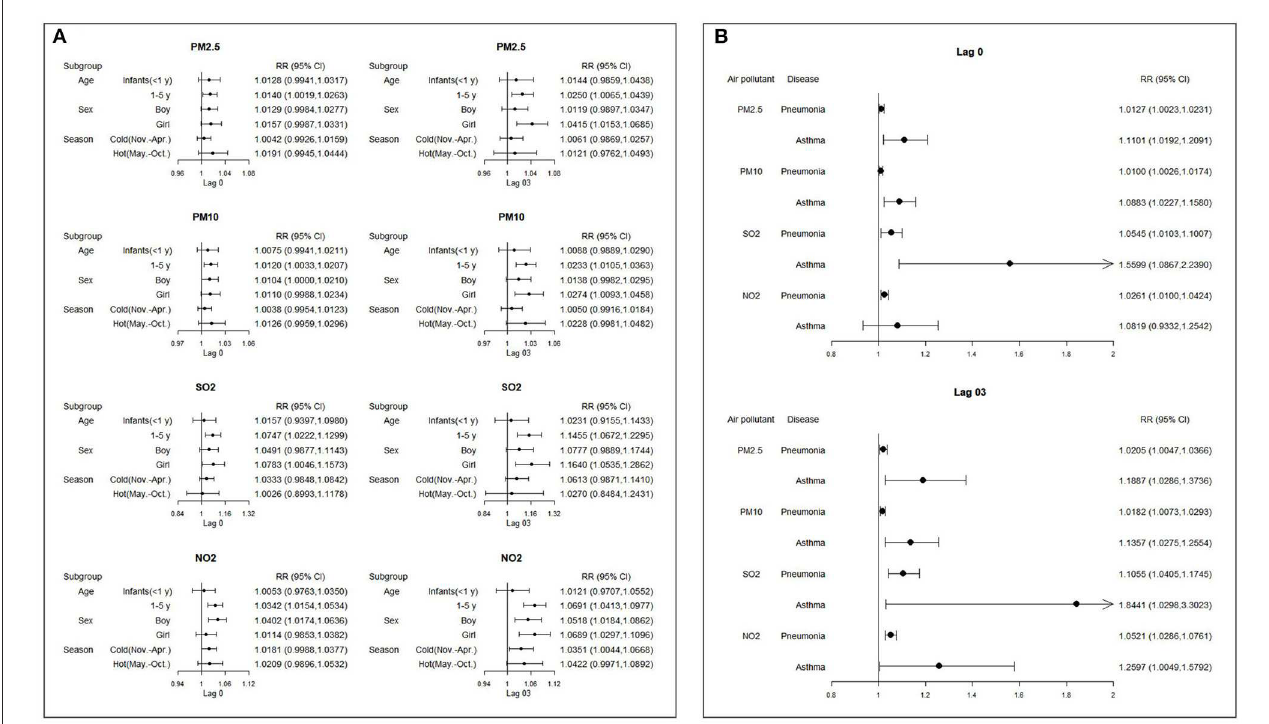
FIGURE2 RR (Rate ratios) and 95% CIs (confidence intervals) following a 10- µ g/m3 increase on lag0 and lag03 of all cases and different subgroups ambient air pollution concentrations and hospital admissions for pneumonia and asthma. (A) Subgroup analyses by age, sex and season. (B) Subgroup analyses by